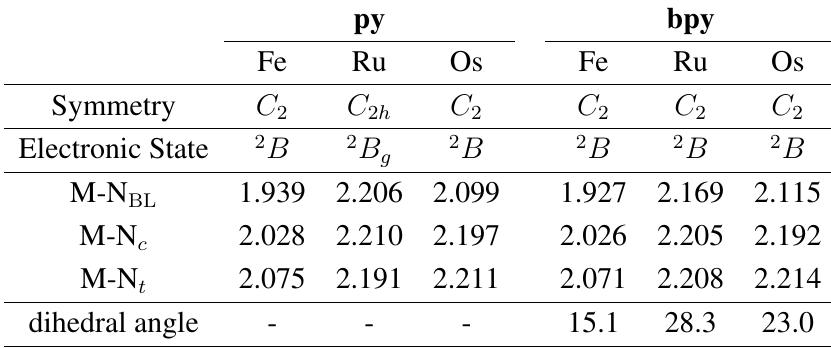
bond length is averaged c